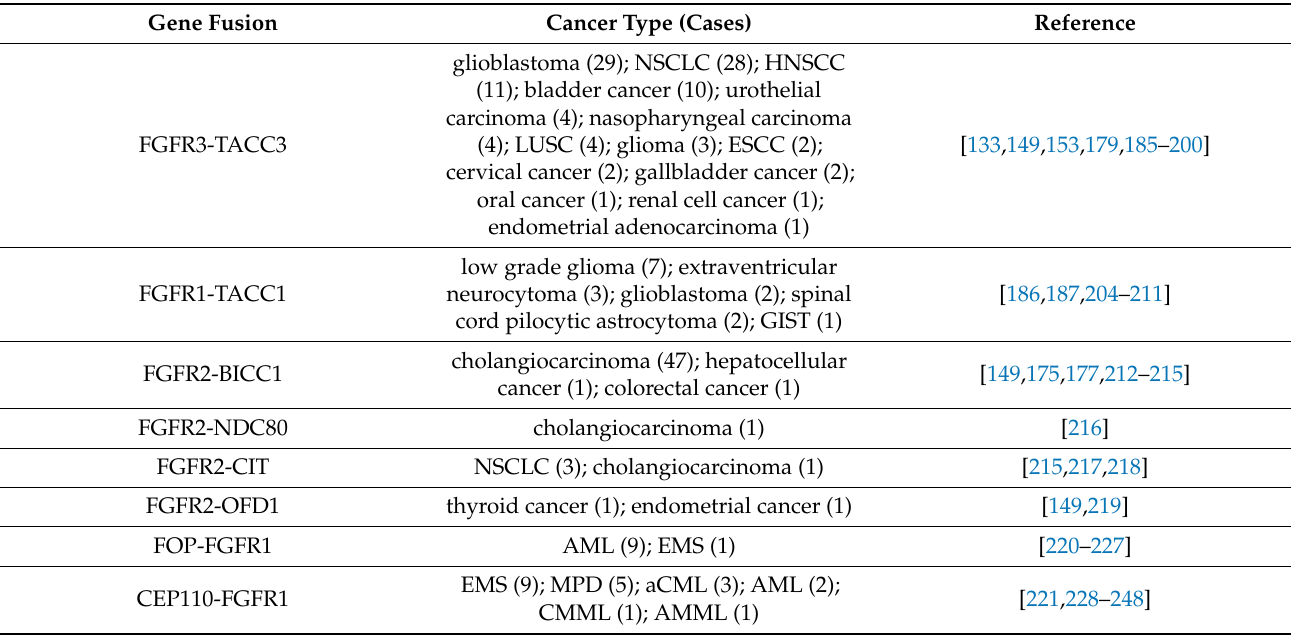
Table 1. FGFR fusion proteins in